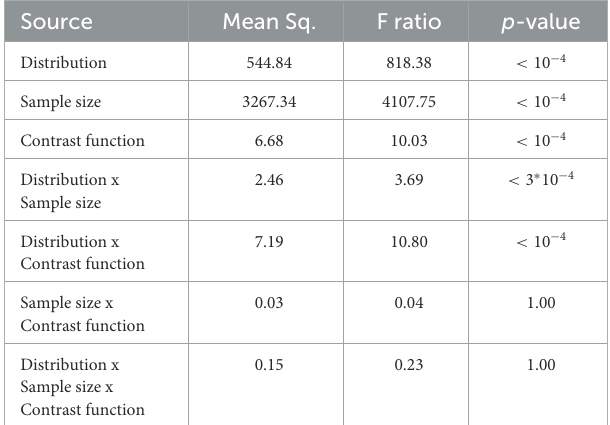
TABLE 1 Analysis of variance of estimation error for 5D datasets.